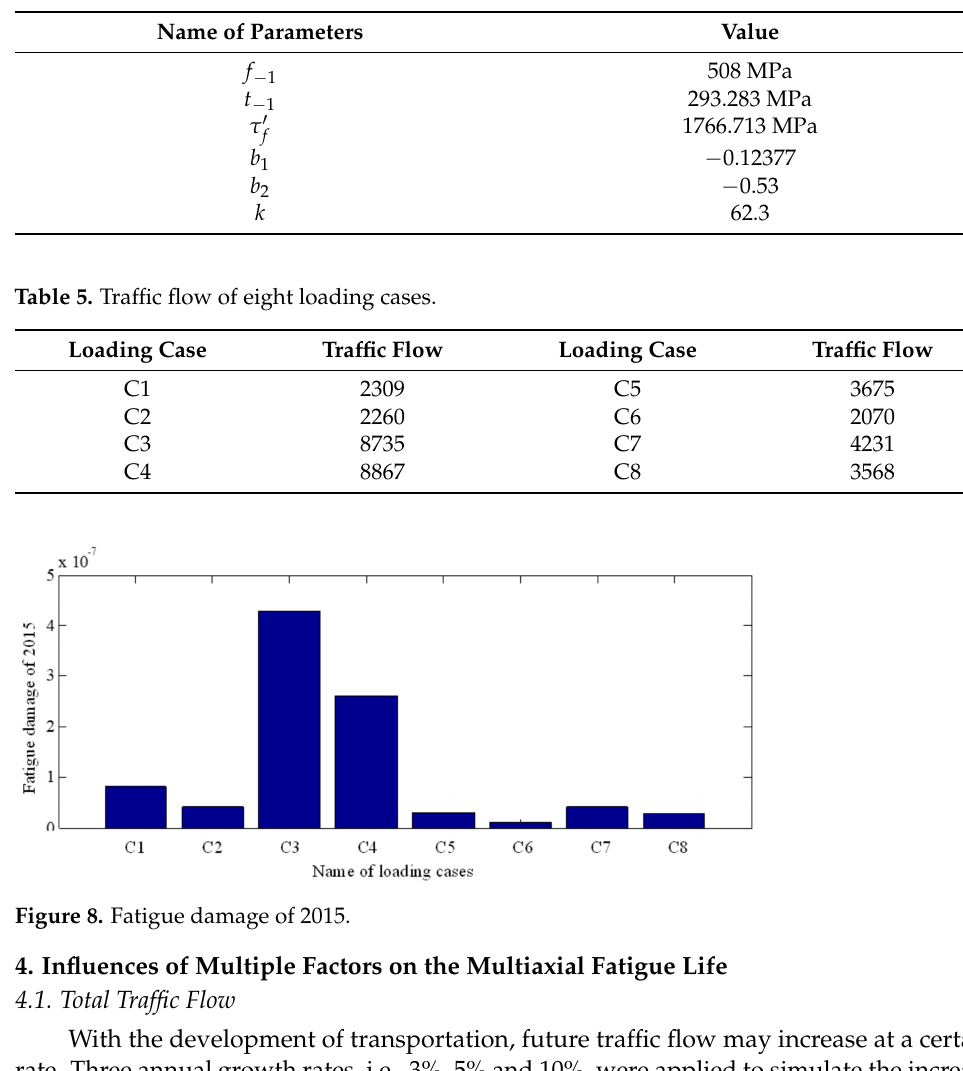
Table 4. Fatigue-related parameters.